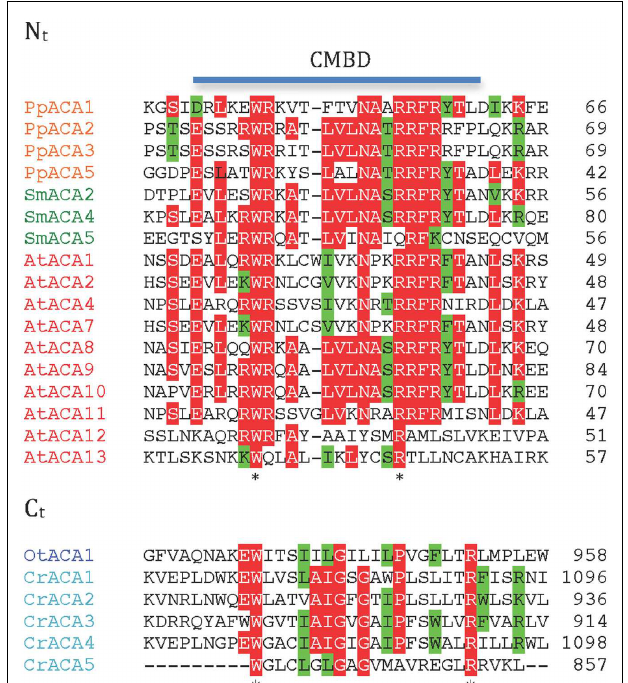
FIGURE 7 |Alignment of putative calmodulin-binding sites in the N- and C-terminal regions ofACA pumps. Nt, N-terminal domain; Ct, C-terminal domain.